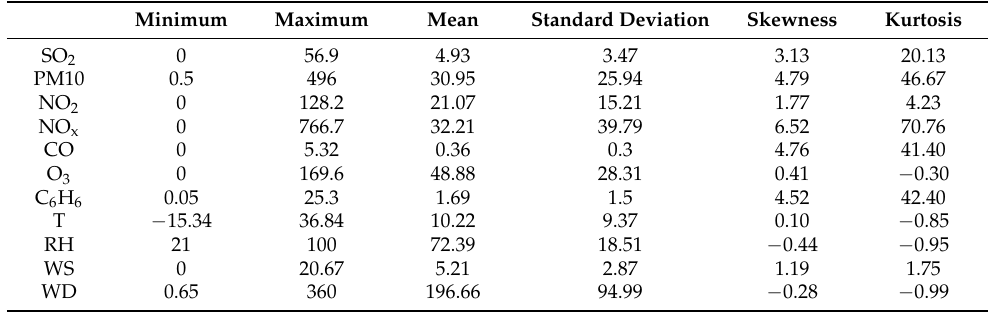
Table 1. Descriptive statistics of the